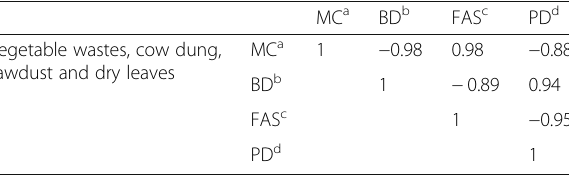
Table 6 Pearson ’ s correlation between physical properties during composting process